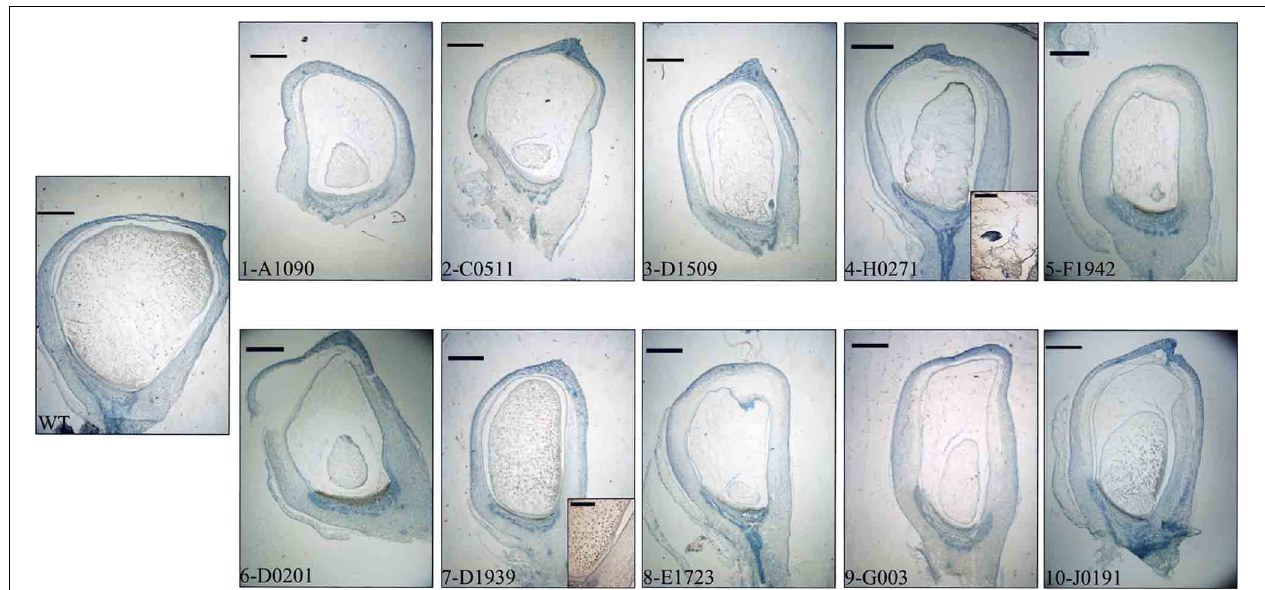
FIGURE 5 | Seeds from each line were sagittally cut and sectioned at 8 µ m thickness. Low magnification images (15 × ) are shown for comparison of general kernel structure and size. The WT kernel shown corresponds to line A1090. Scale bars represent 1mm in main panels and 50 µ m in insets.